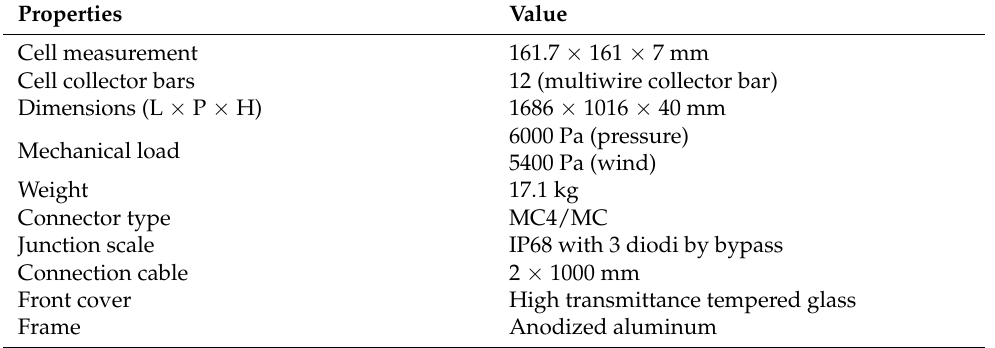
Table 6. Mechanical properties of PV